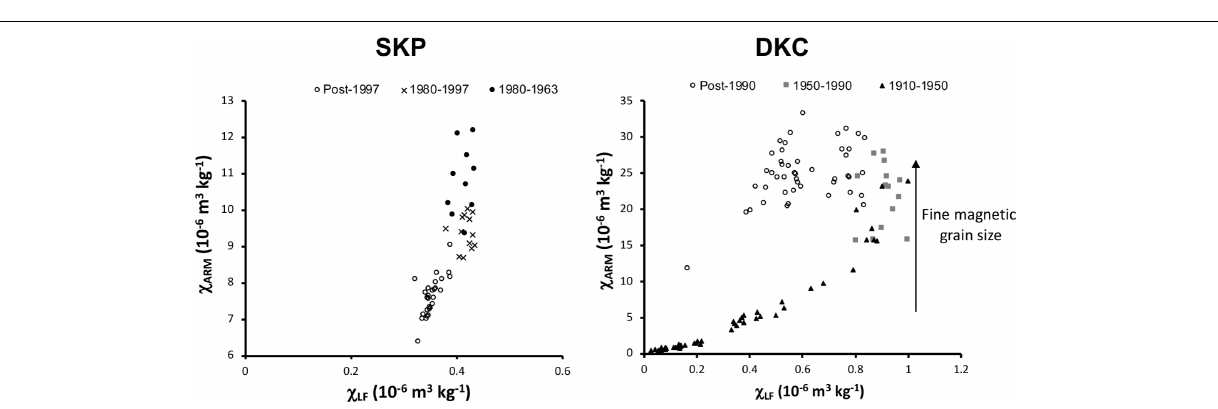
FIGURE 8 | Temporal changes in ferrimagentic grain size indicated by χ LF versus χ ARM (after King et al., 1982) for SKP and DKC. Distinct temporal phases identified from the magnetic flux profiles are shown for SKP (1963–1980, 1980–1997 and post-1997) and for DKC (1900–1950, 1950–1990 and post-1990). Shifts in relative grain size variations are determined since χ ARM values are sensitive to the contribution of single stable domain (SSD) and pseudo stable domains (PSD), with a physical grain size < 2 µ m. χ LF reflect the concentration of total ferrimagentic grains. Linear increases are indicative of increasing magnetic concentration, however, steeper slopes as shown, indicate finer ferrimagnetic grain size